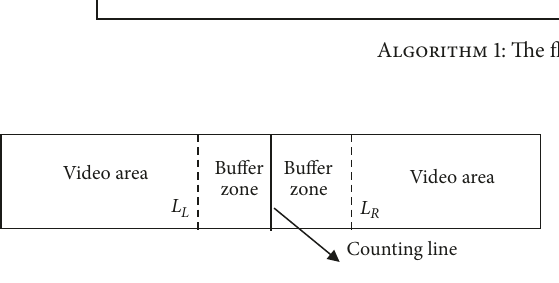
Figure 3: Single line counting method with buffer zone.